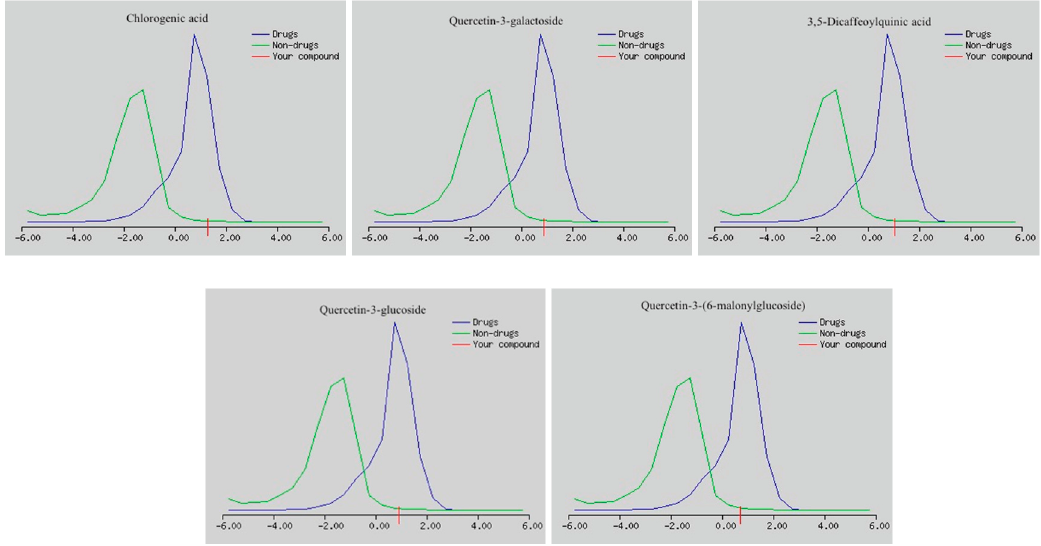
Figure 6. Drug-likeness scores of the main components present in the C. olitorius extract. Table 2. ADME (absorption, distribution, metabolism, excretion) properties and drug-likeness scores of the main components present in the C. olitorius extract.